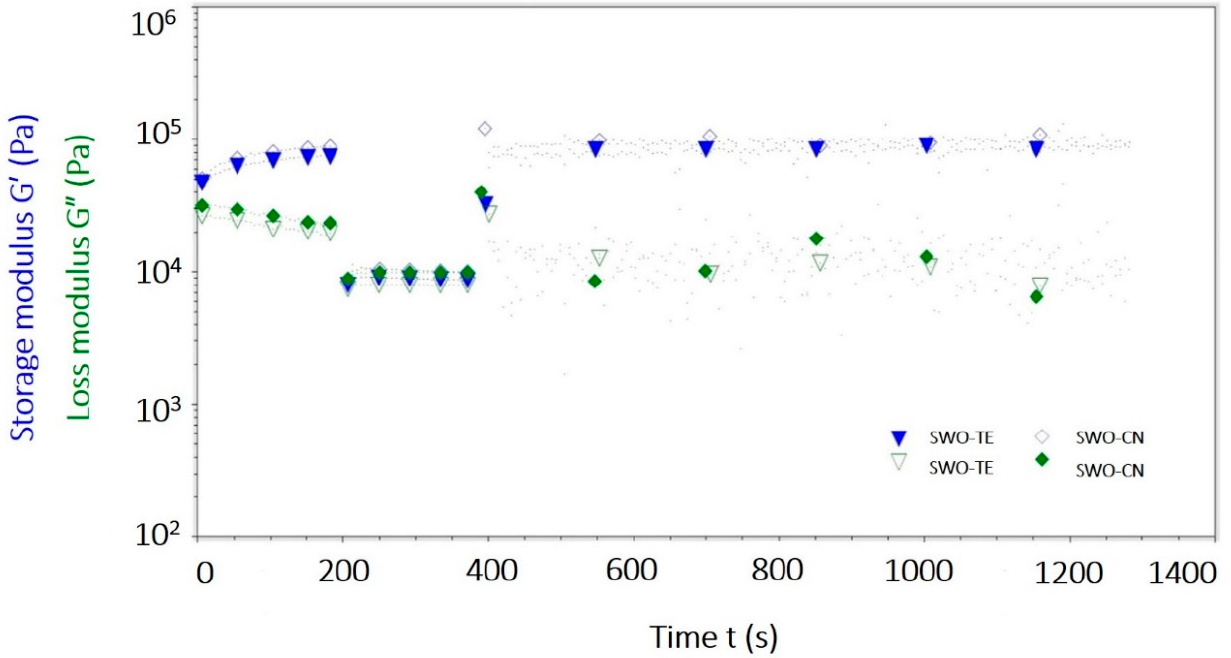
Figure 3. The time sweep test graphics of the oleogel samples (SWO-TE: sunflower wax oleogel with thyme, SWO-CN: sunflower wax oleogel with cumin).